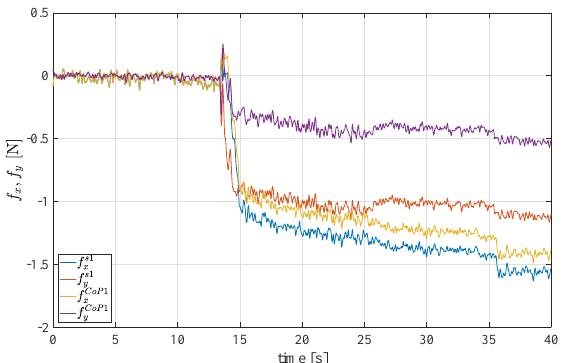
Figure 21. Fourth experiment: Force components rotated into the CoP frame.